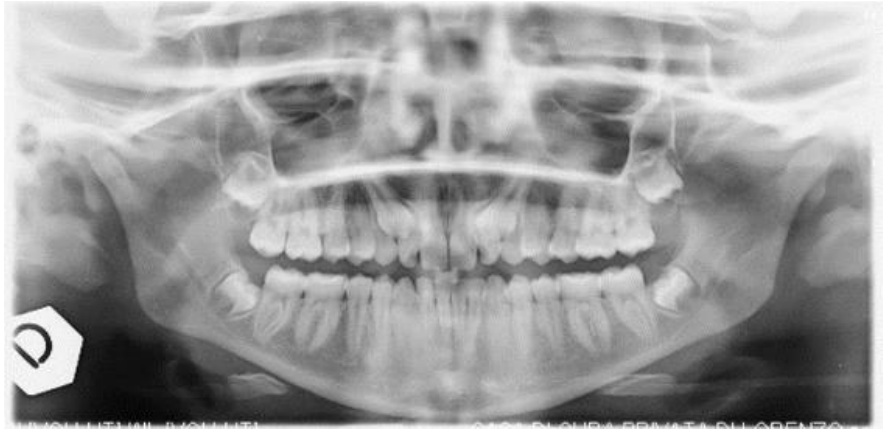
Figure 1. Orthopanoramic X-ray pre-treatment.